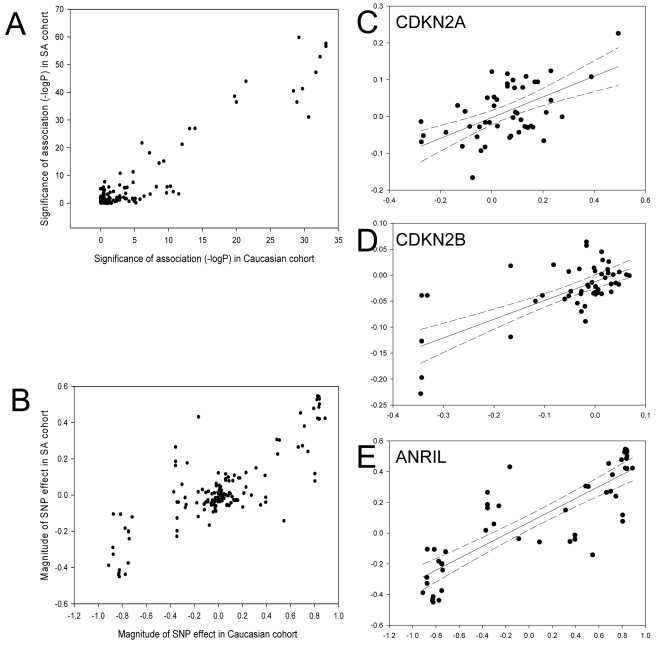
SNP effects in the SA and Caucasian cohorts.Scatter plots show the correlation between aeQTL results obtained in the SA (Y-axis) and Caucasian cohorts (X-axis) for: (A) significance of association with expression (−log P value) for all three genes; (B) effect size at each SNP for all three genes; (C) effect size at each SNP for CDKN2A only; (D) effect size at each SNP for CDKN2B only; (E) effect size at each SNP for ANRIL only. Linear regression line for the association is shown as a solid line with the 95% confidence intervals shown as dotted lines.